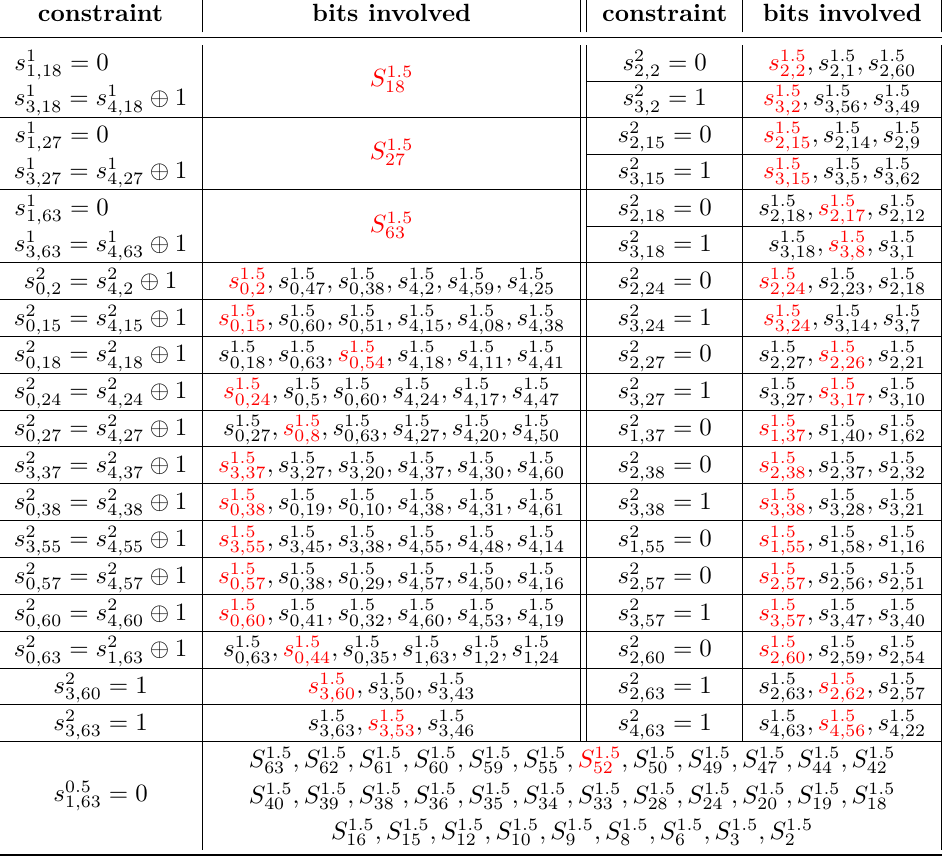
Table 11: This table shows the bits involved for each constraint in LB3. s n r th row and c th column state value at round n . S n at round n . Note that the bits highlighted in red are the bits we use to fix the particular